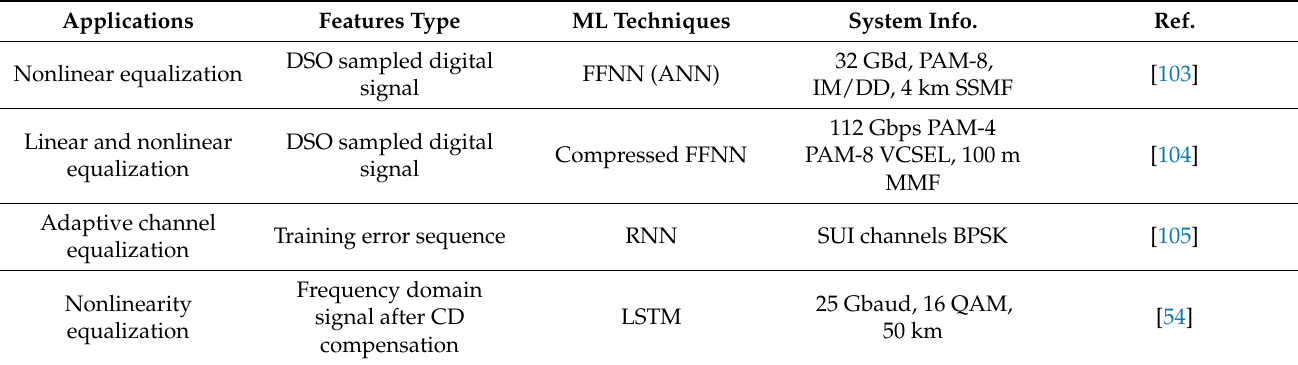
Table 2. Signal processing applications based on machine